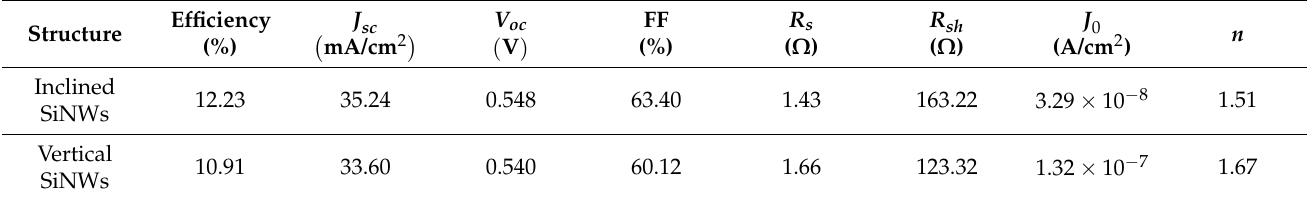
Figure 7. ( a ) Schematic illustration of hybrid solar cells and ( b ) correlated band diagram. Cross- sectional SEM images of ( c ) vertical SiNWs and ( d ) inclined SiNWs when the PEDOT:PSS coating was deposited. Table 1. Photovoltaic performances of two distinct hybrid solar